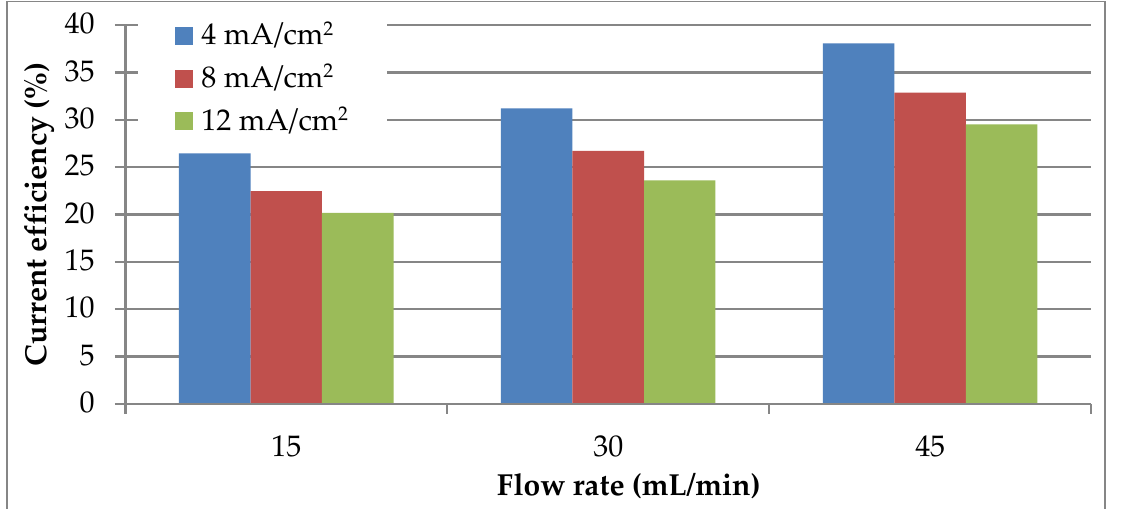
Figure 6. Evolution of current efficiency with electrolyte flow rate at different current densities.